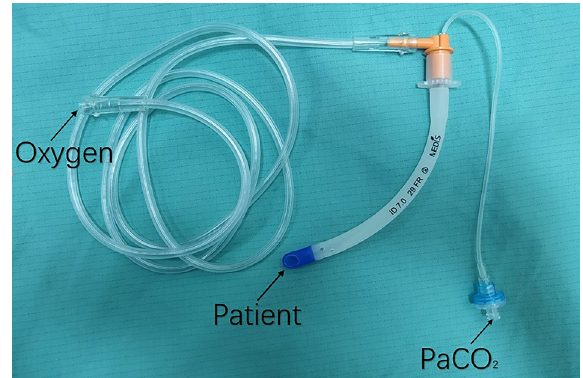
Figure 1. Modified nasopharyngeal airway with an oxygen